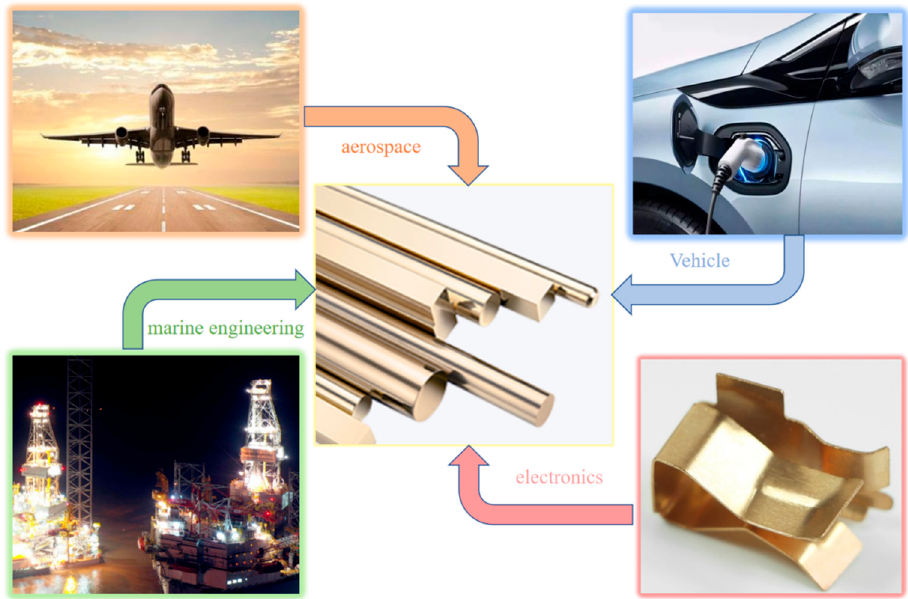
Figure 1. Application of Cu–Ni–Sn alloys.